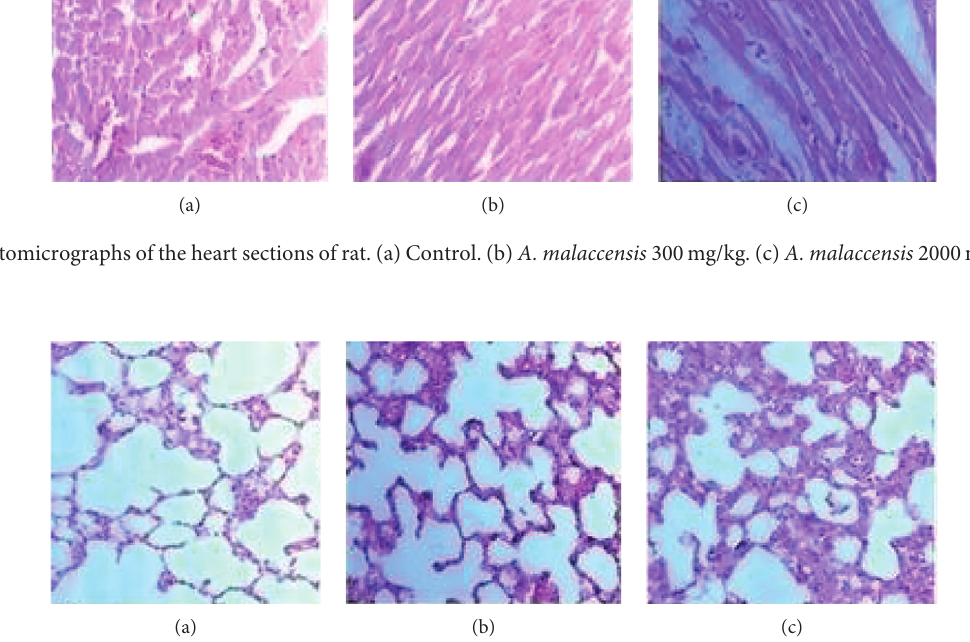
Figure 8: Photomicrographs of the lung sections of rat. (a) Control. (b) A. malaccensis 300mg/kg. (c) A. malaccensis 2000mg/kg. Scale bar, 10 µ